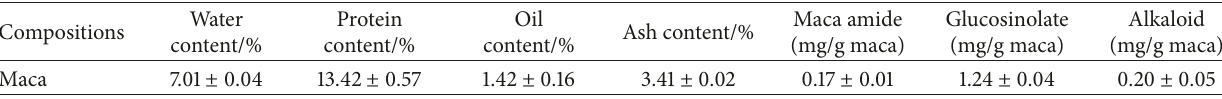
Table 1: Compositions of yellow maca cultivated in Xinjiang.